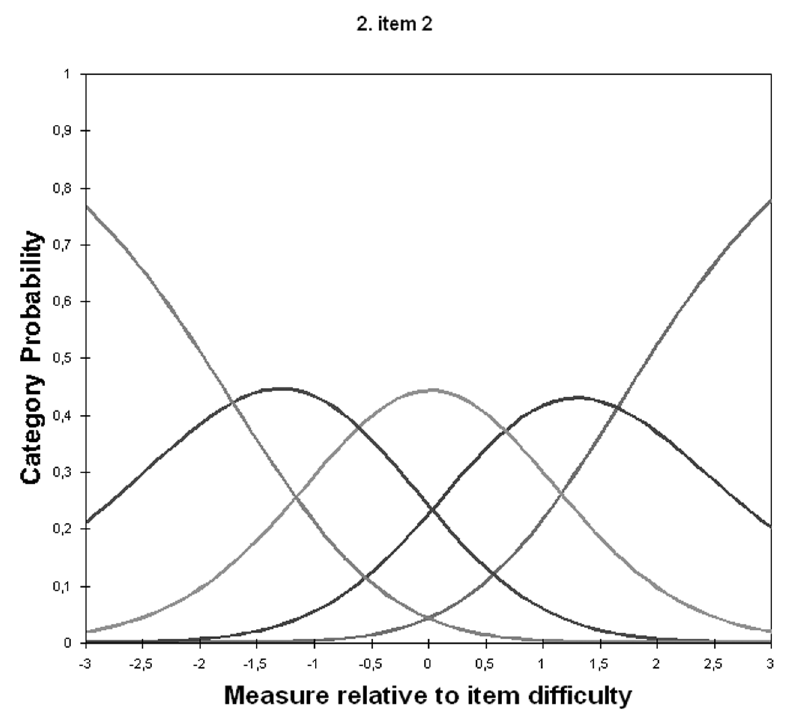
Figure 4. Category